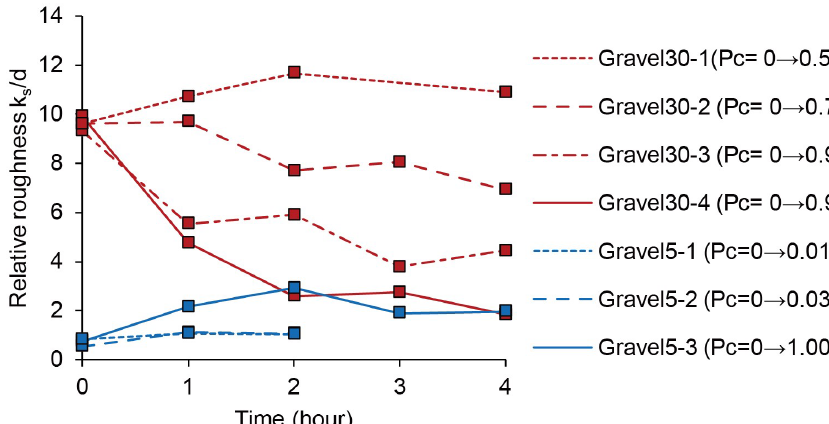
Figure 6. Change in relative roughness with time.